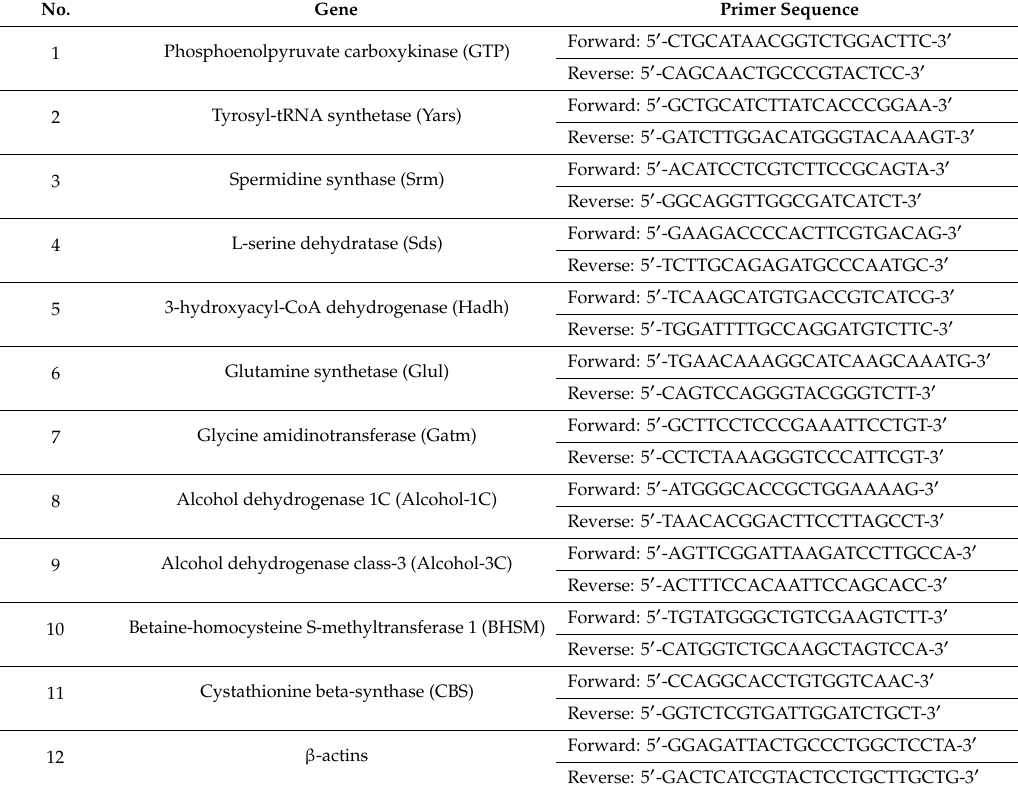
Table 2. Primer sequence for quantitative real-time PCR analysis